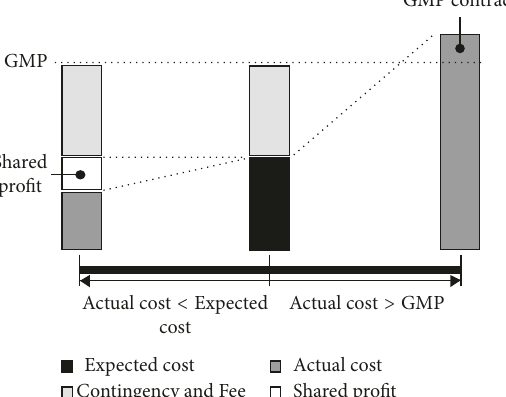
Figure 2: Payoff structure of the GMP contract.